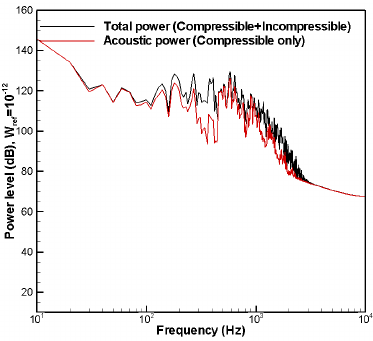
Figure 15. Power level spectrum of total and acoustic component. Appl. Sci. 2017 , 7 , 1137 15 of 16